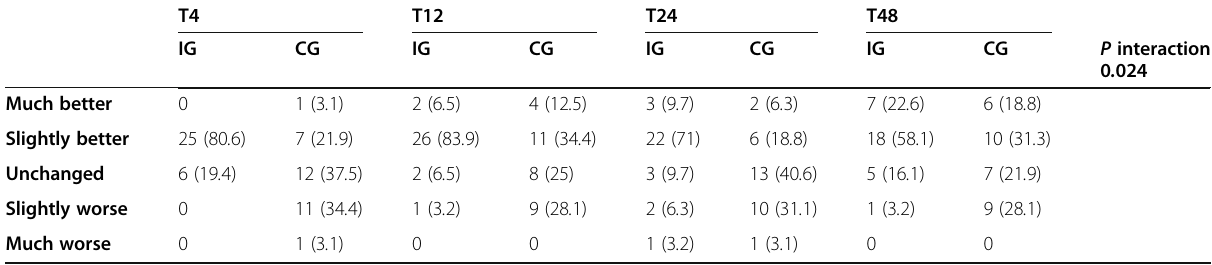
Table 3 Patient satisfaction with treatment over